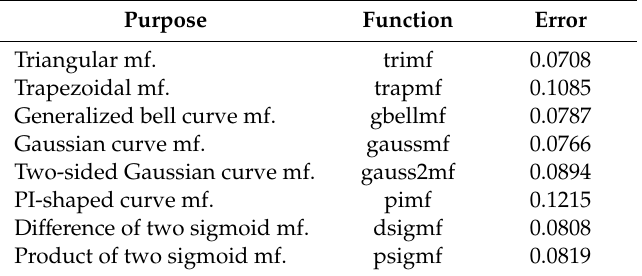
Table 3. Mean square error (MSE) for di ff erent input membership functions.